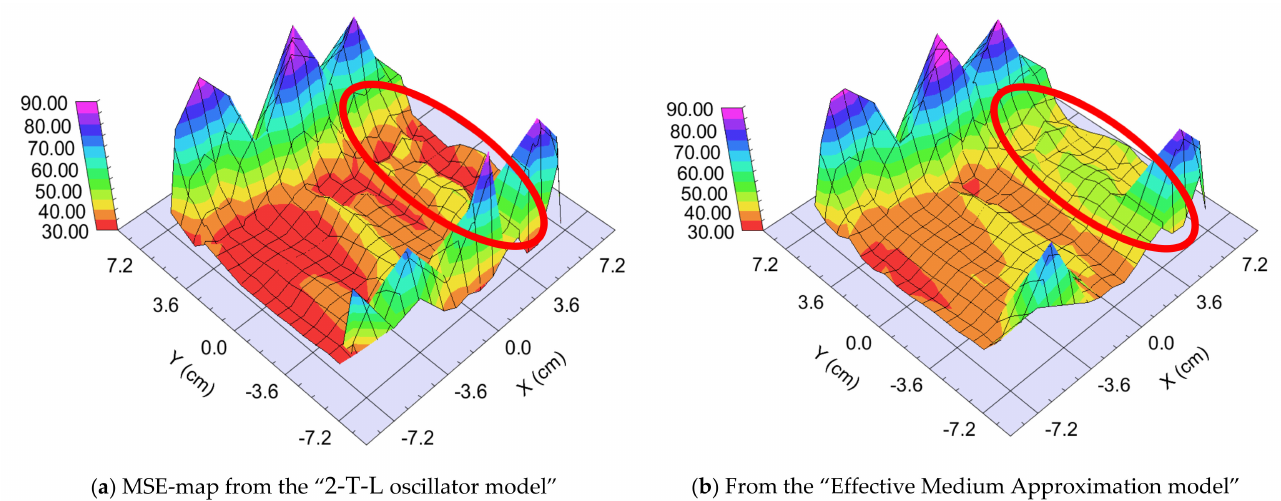
Figure 12. Mean Squared Error (MSE)-maps ( a ) using the 2-Tauc-Lorentz (2-T-L) oscillator model ( b ) and the Effective Medium Approximation model. Red ellipses show the interesting area, where the composition changes the most. We show only one 15 × 15 cm part, all other parts show the same